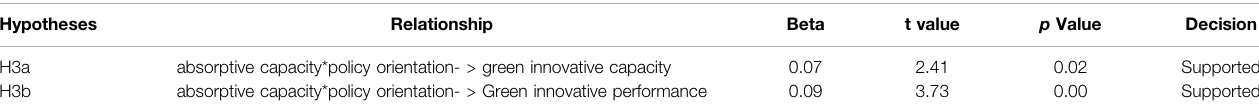
TABLE 7 | Results of moderation effect of absorptive capacity.